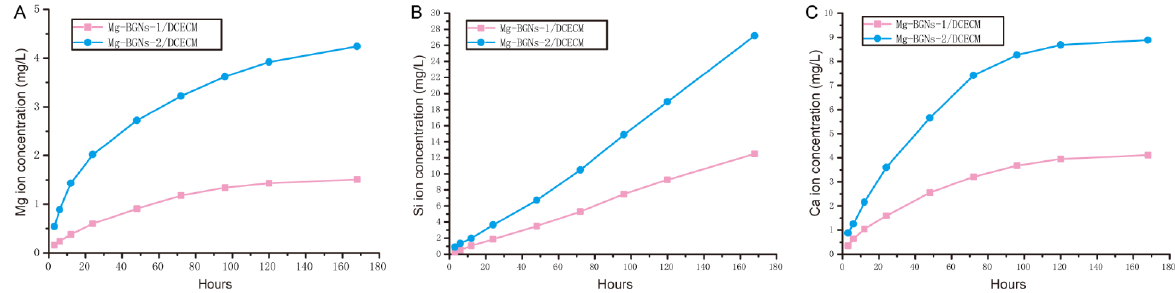
Figure 4. Amount of Mg ( A ), Si ( B ) and Ca ( C ) ions released from Mg-BGNs-1/DCECM and Mg-BGNs-2/DCECM scaffolds as a function of the soaking time in phosphate buffered saline (PBS).